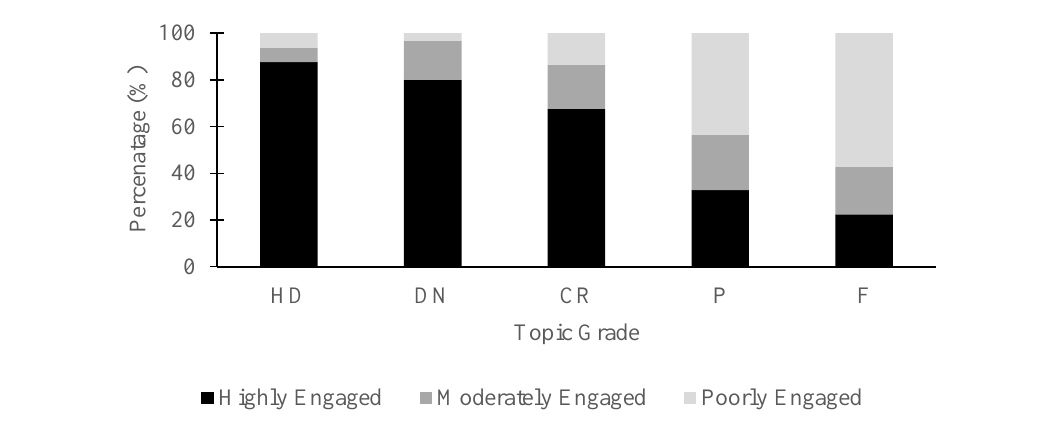
Figure 3: Comparison of level of student engagement to final topic grade. Level of engagement was defined as outlined in table 1. HD=High Distinction (85≥), DN=Distinction (75 - 84), CR=Credit (65 - 74), P=Pass (50 - 64), F=Fail